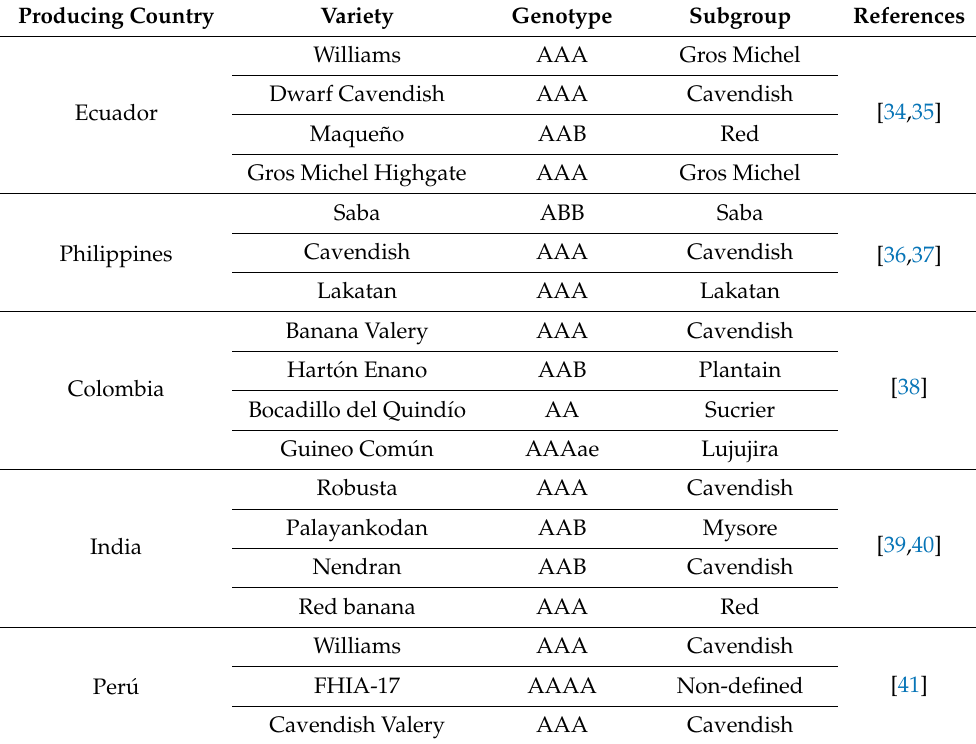
Table 1. Classification of banana varieties based on morphological